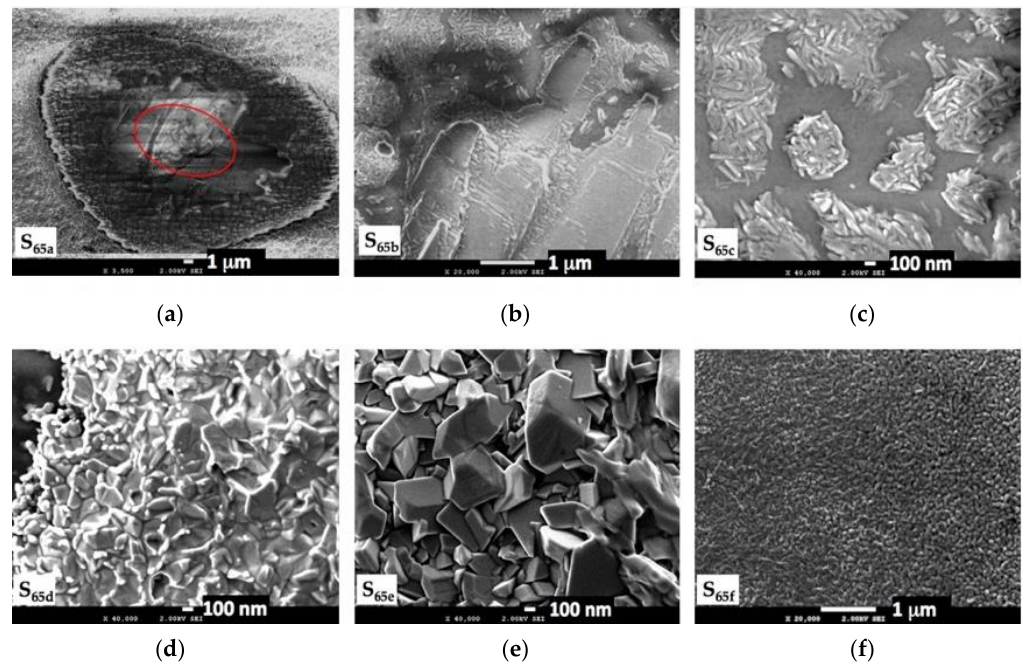
Figure 11. SEM micrograph for the irradiated spot S 65 at a per-pulse laser fluence of 4.2 mJ / cm 2 and 1 min exposure time. ( a – c ) S 65b and S 65c are images that zoom in at the center and the periphery within the crater S 65a ; ( d ) S 65d is a magnified image of the edge zone next to the crater; ( e ) S 65e is a magnified image at the zone besides S 65d toward the edge of the laser-modified region; ( f ) S 65f corresponds to the very outer edge of the laser-modified zone.